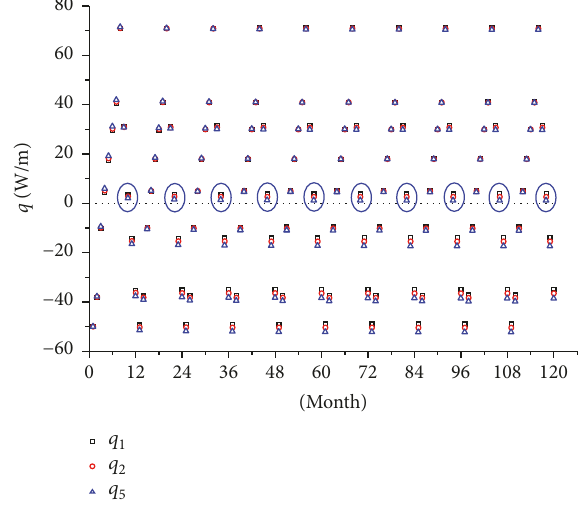
Figure 8: Monthly average heat fluxes for different boreholes (spacing = 7